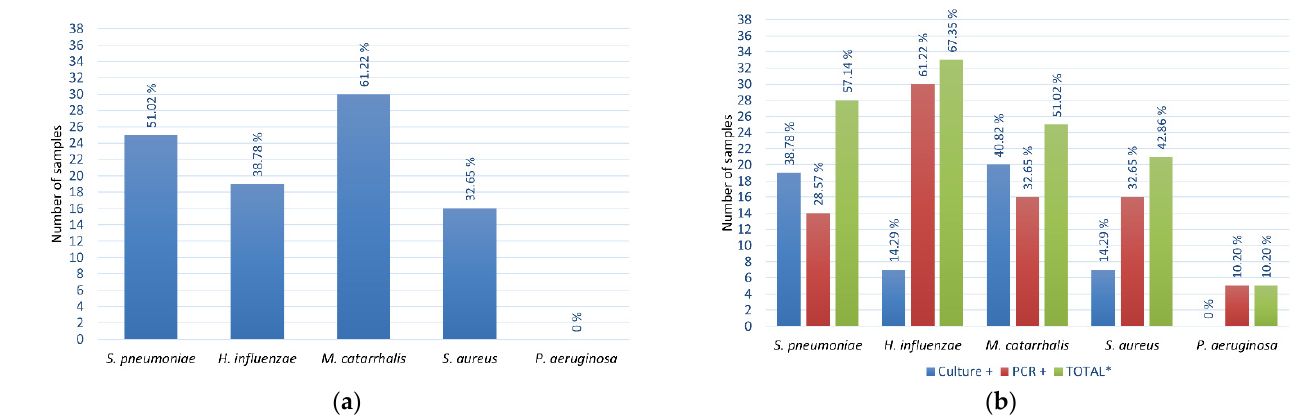
Figure 2. Number of bacterial isolates (percentage of total patients/samples) identified by ( a ) culture in nasopharyngeal samples and ( b ) culture and qPCR in middle ear fluid samples from children with OM. * The total corresponds to the sum of Culture+ and PCR − with Culture − and PCR+ and Culture+ and PCR+ samples.